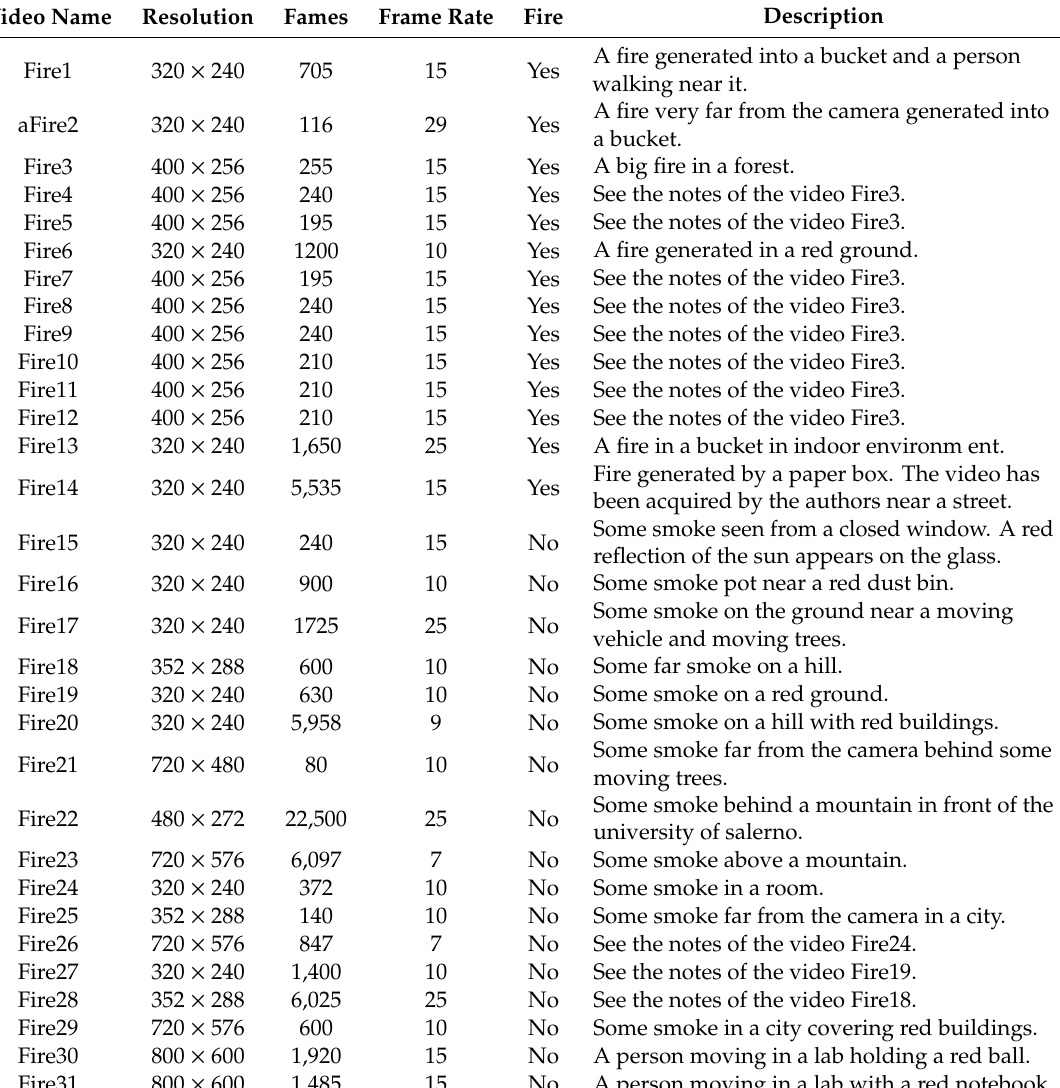
Table 5. The dataset information